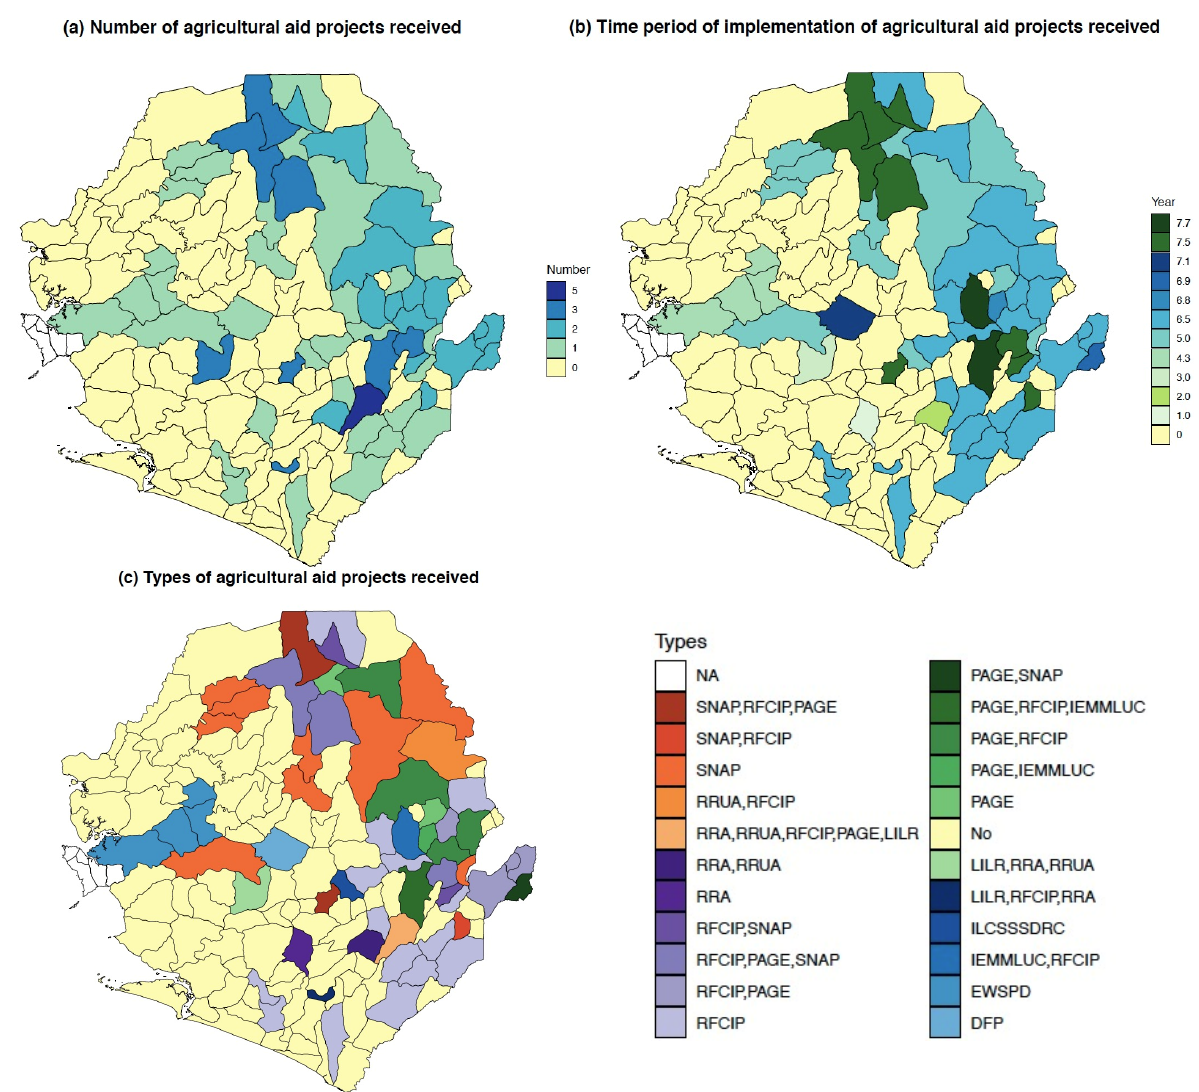
Figure 1. Description of Sierra Leone’s chiefdom-level agricultural aid projects from 2001 to 2015.